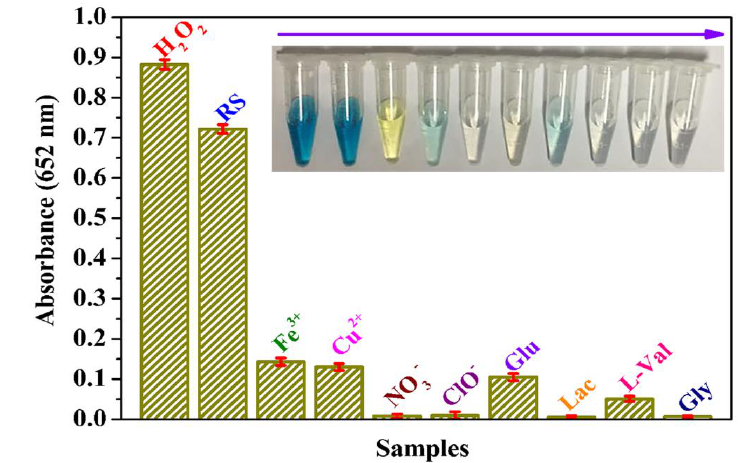
Figure 7. Reveal sample (antiseptic liquid was diluted 1000 times) and selectivity analysis with interfering substances (20.0 mM of Fe 3+ , Cu 2+ , NO 3 − , ClO − , Glu, Lac, L-Val, and Gly) of MoS 2 @CNNS(30)-based assay system by monitoring the absorbance at 652 nm. Inset: related color changes.